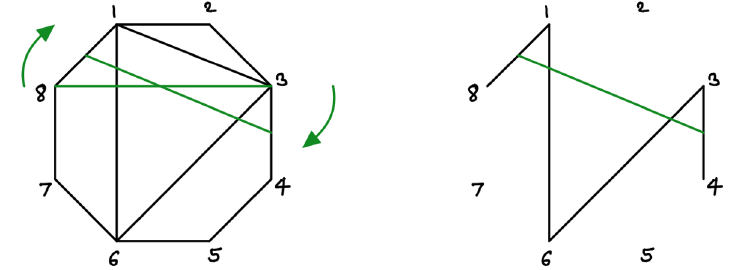
Figure 1 . The diagonal (38) of the (dual) octagon is compatible with the reference {13,36,16}.